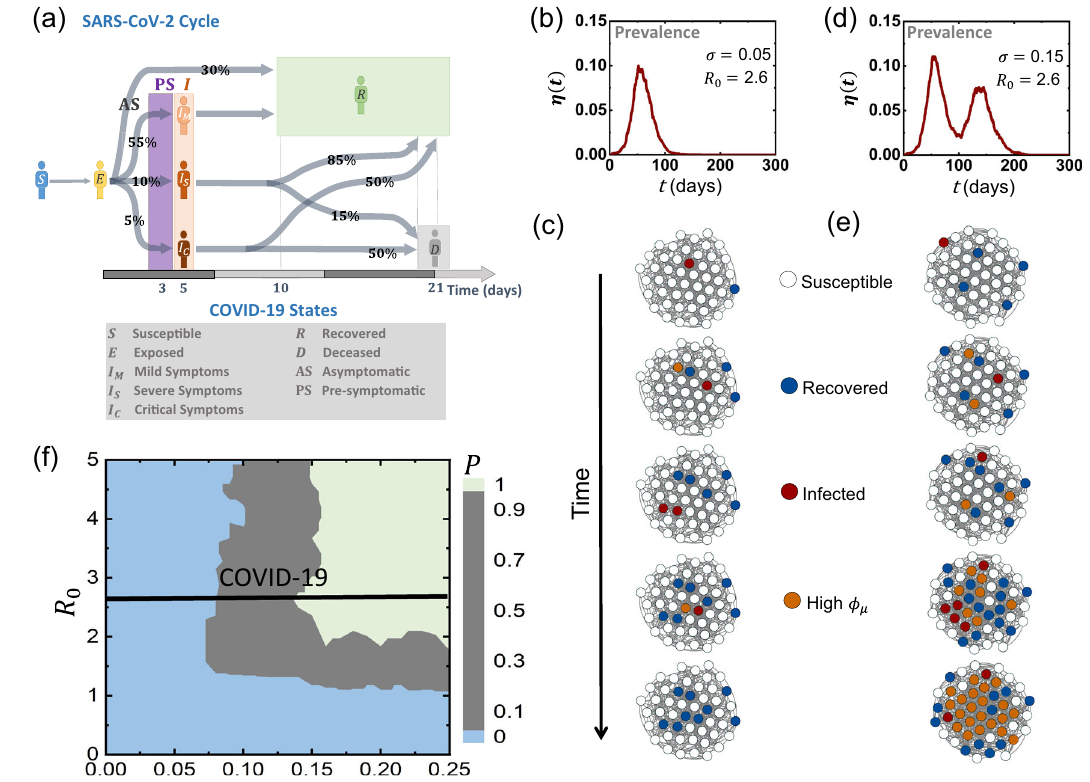
Fig. 5 | Reemergence due to immunity evasion. a The SARS-CoV-2 disease cycle. Upon exposure ( E , yellow) individuals enter a pre-symptomaticphase (PS, purple), from which they later develop mild ( I M ), severe ( I S ) or critical ( I C ) symptoms, determiningthedurationoftheirinfectedphaseandtheirprobabilitytorecover( R , green) or decease ( D , grey). The probability of all transitions appears along the arrows, and the typical time-line is shown at the bottom of the cycle. 30% of exposedindividualsshownodetectablesymptomsatall(AS). b , c Undersmall σ